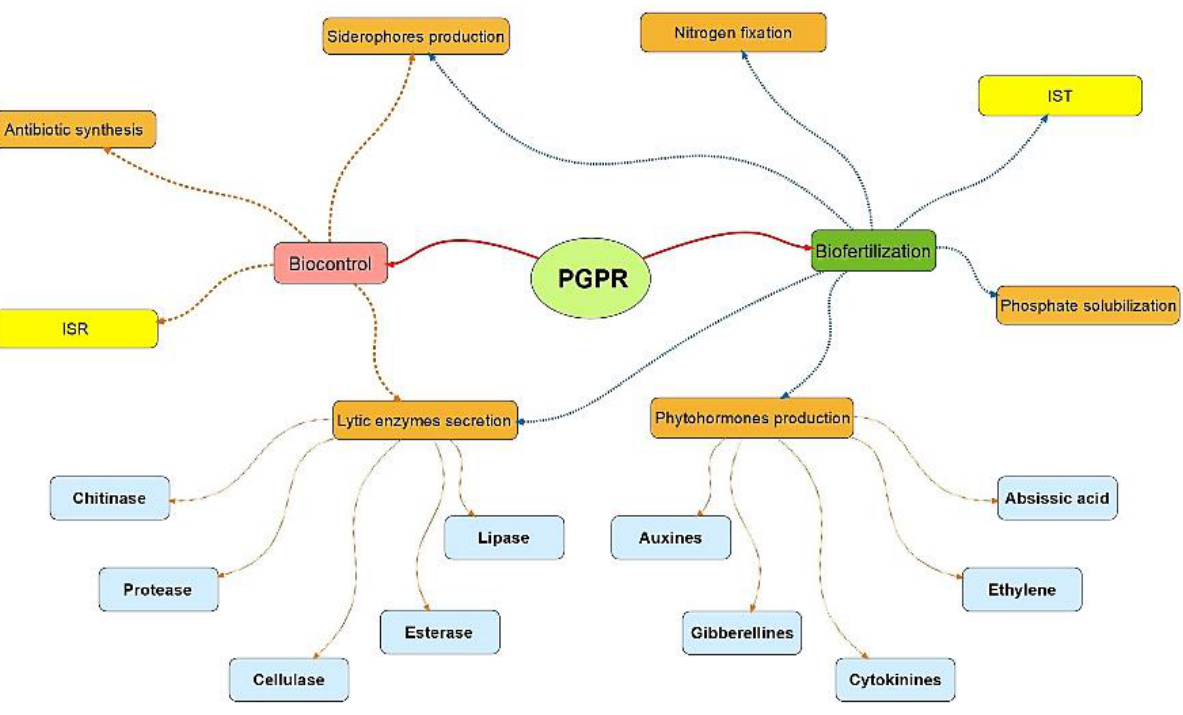
Figure 2. PGPR metabolites for soil remediation and crop improvement. ISR: Induced Systemic Resistance. IST: Induced Systemic Tolerance (realized using the Visual Understanding Environment software, VUE 3.3.0-developped by Tufts university, Medford, MA,